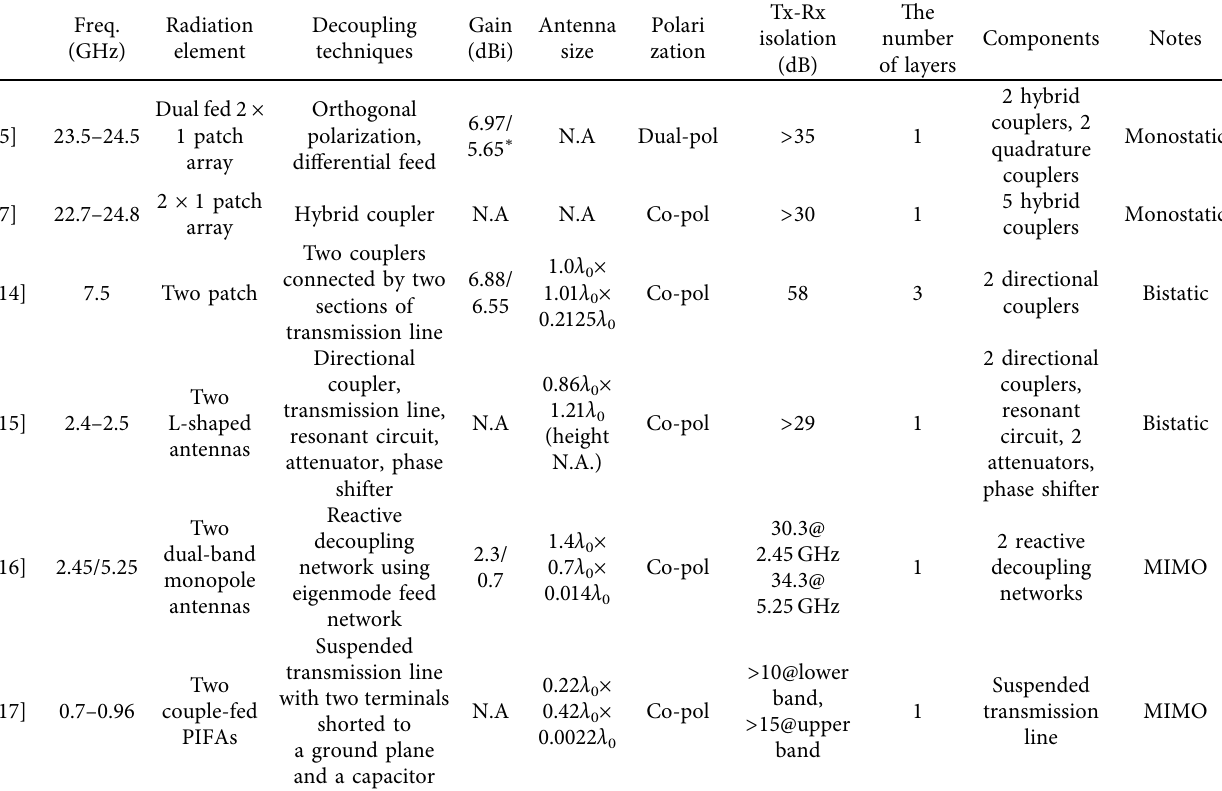
Table 2: Comparison between the proposed antenna and reported high-isolation designs.